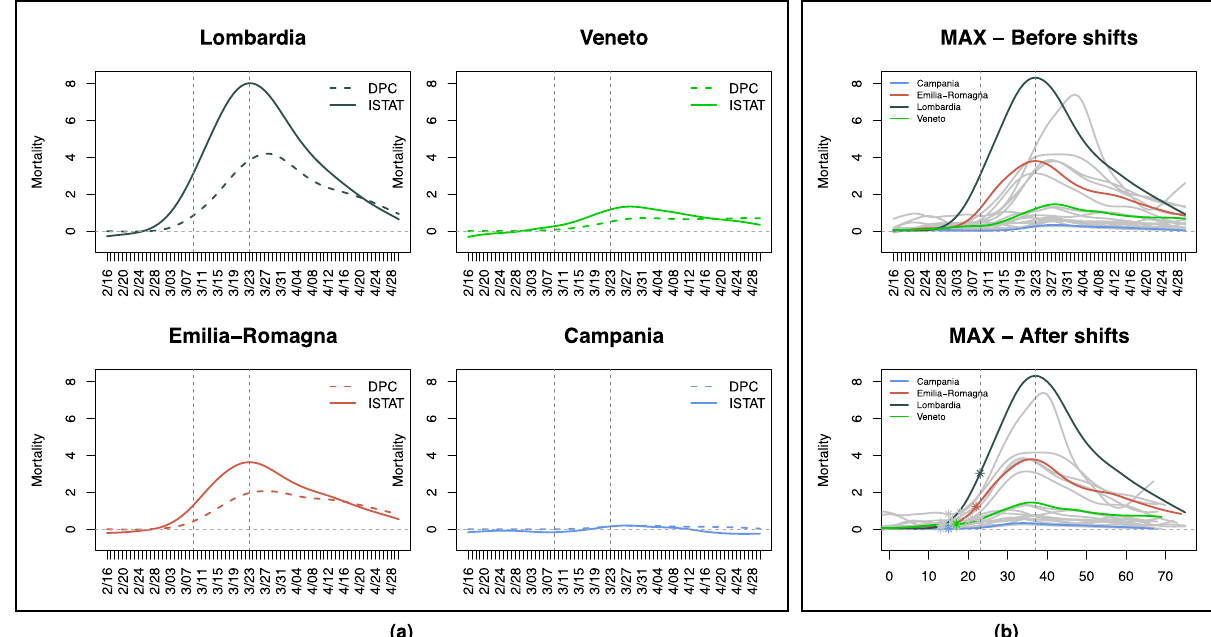
Figure 1. Mortality curves. ( a ) DPC (dashed) and ISTAT (solid) differential mortality curves (per 100,000 inhabitants) in four example regions; Lombardia, Veneto, Emilia Romagna and Campania. Curves are smoothed with splines, with degree of smoothing selected by generalized cross-validation (see Methods). ISTAT curves “take off” earlier and in some regions are as much as twice as high at their peak—possibly due to many COVID- 19 deaths happening at home and/or not being recorded as such in hospitals, especially in the early stages of the epidemic. ( b ) MAX mortality curves (per 100,000 inhabitants) in the 20 Italian regions, before (top) and after (bottom) the shifts produced by probKMA run with K = 2 . In the bottom panel, time is marked as a day number (as opposed to a date); this represents the region-specific time of the epidemic unfolding, and corresponds to actual time (starting on February 16 and ending on April 30) only for regions with no shifts, e.g., Lombardia). Curves are again smoothed with splines, with degree of smoothing selected by generalized cross-validation. Lombardia, Veneto, Emilia Romagna and Campania, also shown in ( a ), are highlighted in color. In all panels, vertical lines mark the dates of the national lock-down (March 9) and of the suspension of all nonessential production activities (March 23). In the bottom panel of ( b ) vertical lines still show these dates without shifts; stars on the curves mark the lock-down after the region specific